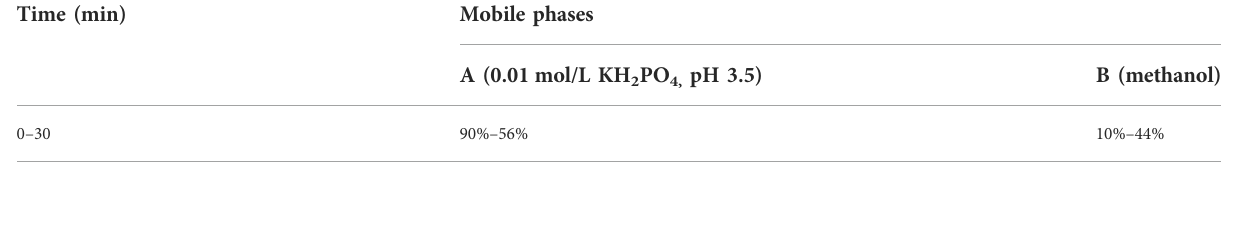
TABLE 1 Gradient elution program for alkaloids (detection wavelength: 239 nm).